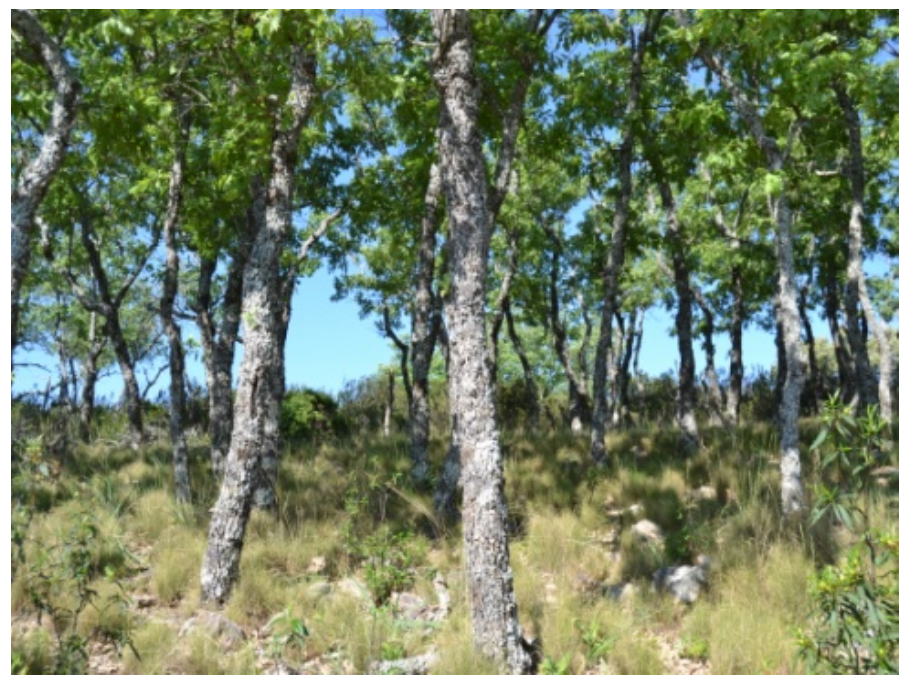
Figure 9. Supramediterranean Pyrenean oak wood of Quercus pirenaica in Sierra Morena. Sorbo torminalis–Quercetum pyrenaicae with grassland of Avenulo occidentalis–Festucetum elegantis.